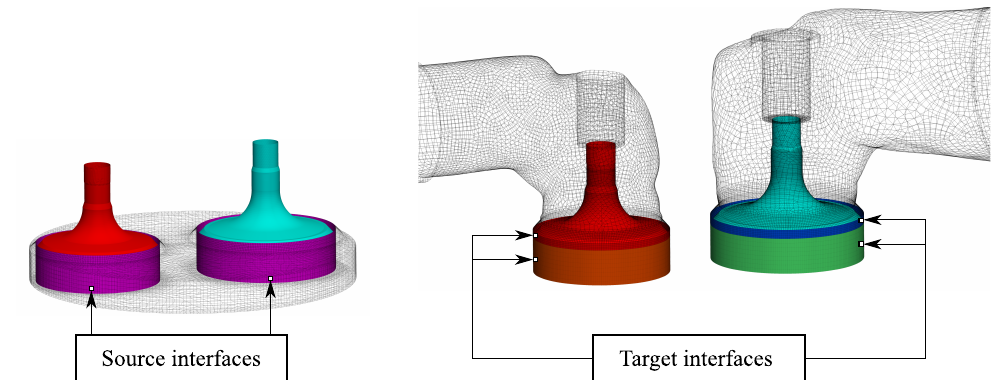
Figure 6. Detail of the source and target sectors of the pseudo-supermesh